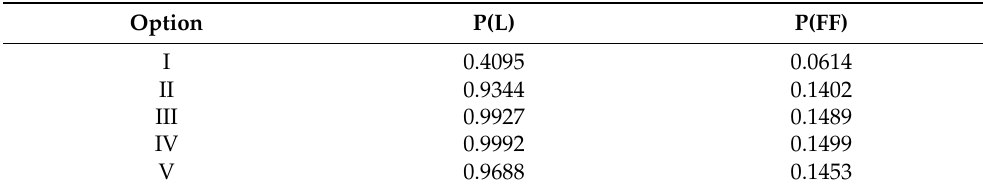
Table 3. Probability of a forest fire from thunderstorm activity, taking into account the influence of soot particles on the formation of a thunderstorm front in the spring for scenario B.